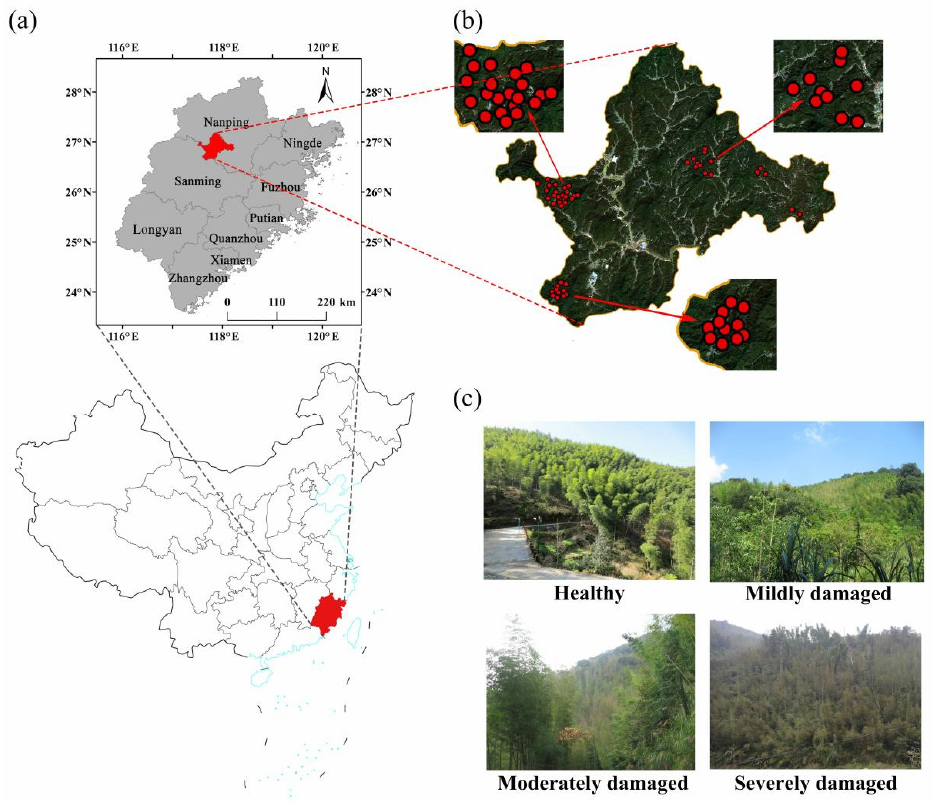
Figure 1. Study area: ( a ) Shunchang County; ( b ) sample collection site; ( c ) moso bamboo with different levels of PPC damage.